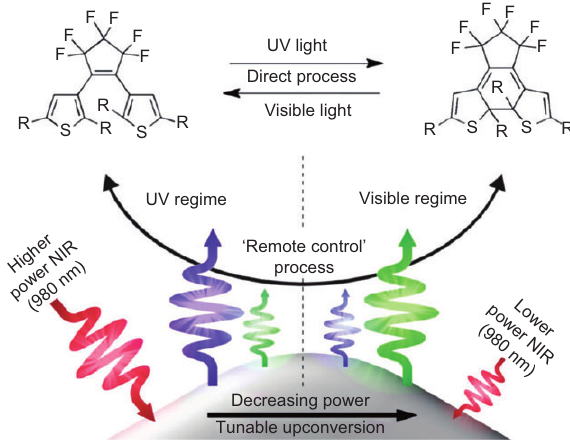
Figure 21 The “ direct ” photoreactions of the DTE derivatives are trig- gered by UV light (for ring closing) and visible light (for ring opening); these reactions can also be triggered in a “ remote control ” process using the UV light generated under high-excitation power densities and the visible light generated under low-excitation power densities when the UCNPs (ErTm and TmEr) absorb NIR (980 nm). The sizes of the col- ored arrows represent the relative amount of each type of light excited or emitted during the multiphoton process [124] . Reprinted with permis- sion from Ref. [124] . Copyright (2010) American Chemical